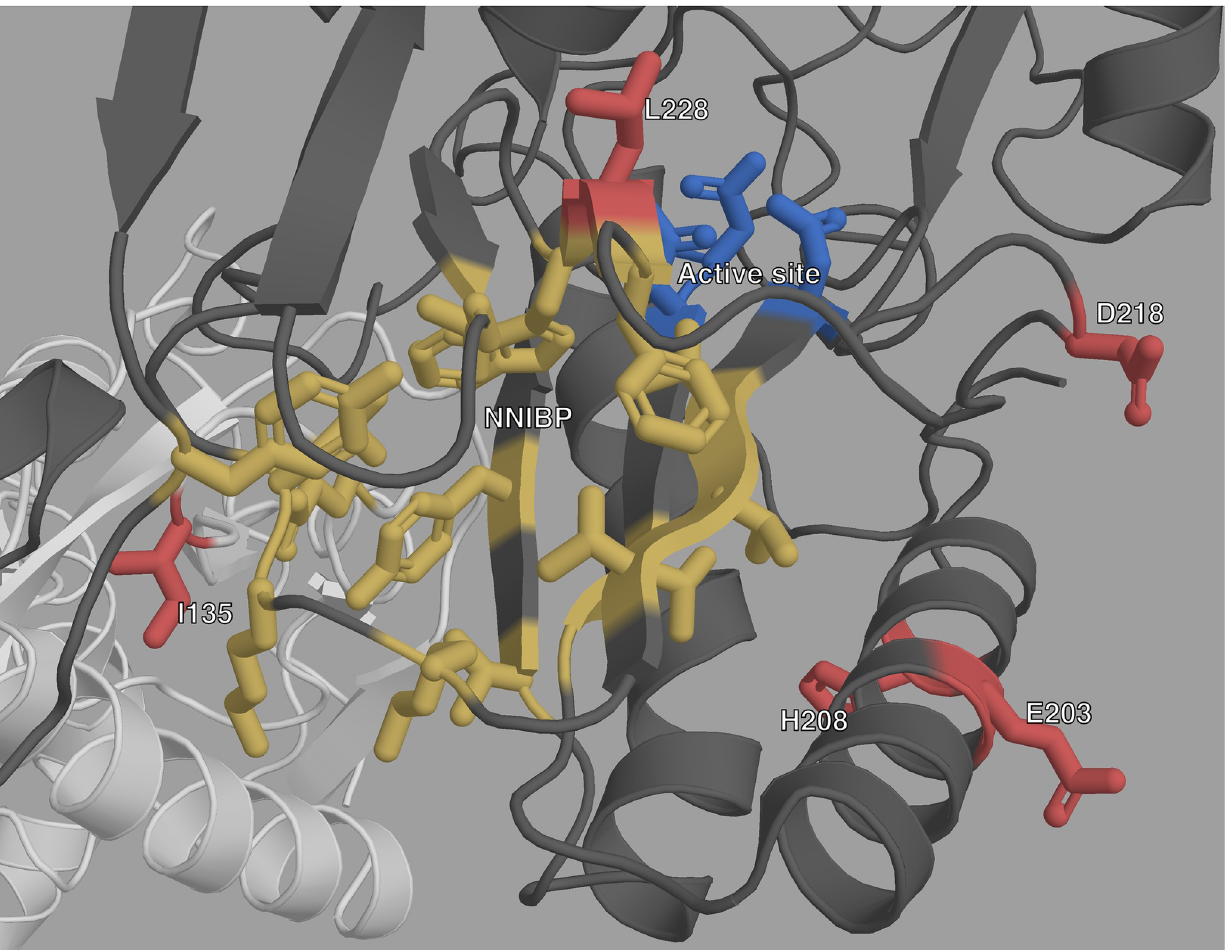
Fig 4. Structure of HIV-1 RT with highlighted important sites. The p66 subunit is colored dark gray and the p51 subunit white. The active site is highlighted in blue, and the NNIBP is highlighted in yellow. The sites of new mutations are colored in red.